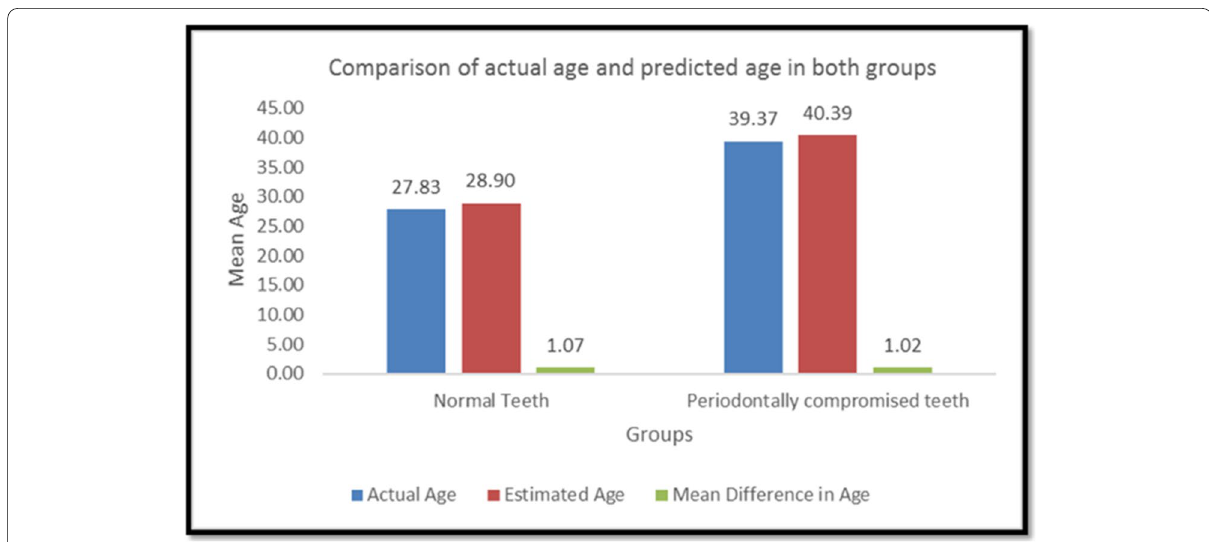
Fig. 5 Graph showing the comparison of actual age and predicted age in both groups